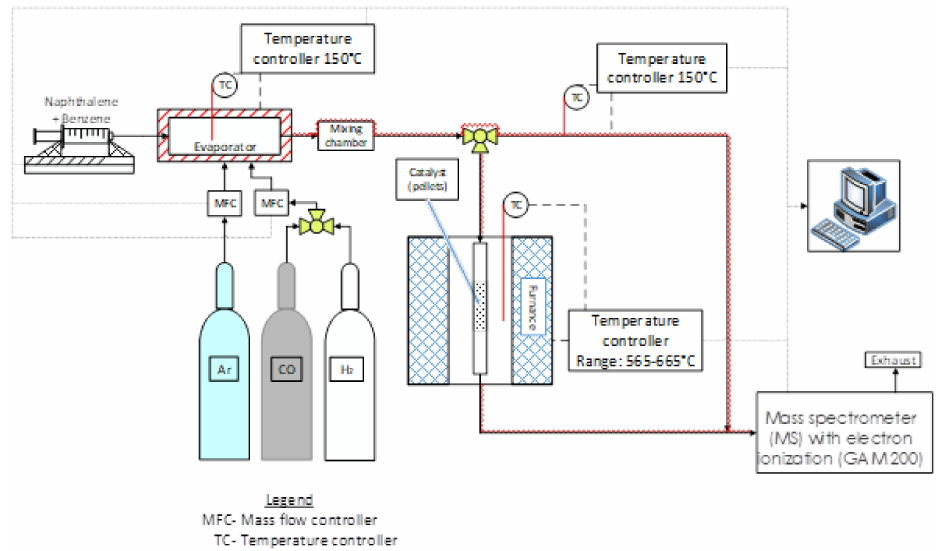
Figure 11. Representation of bench-scale workplace for tar decomposition.